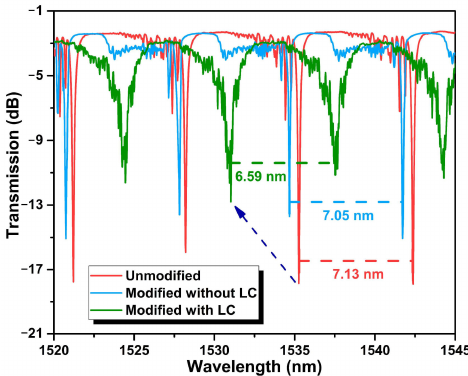
Figure 4. WGM spectra of the unmodified and modified